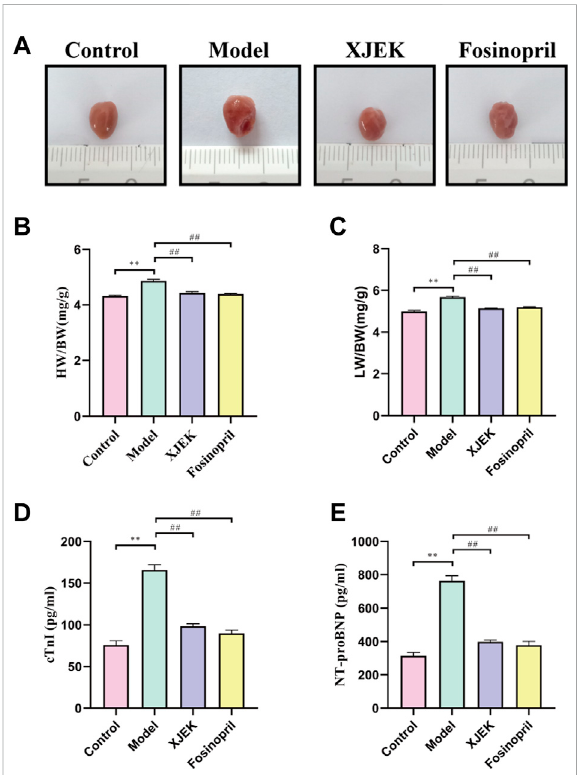
FIGURE 2 XJEK attenuated MIR-induced cardiac injury. (A) Pictures of the hearts from mice. (B) Ratios of heart weight to body weight (mg/g). (C) Ratios of lung weight to body weight (mg/g). Serum cTnI (D) and NT-proBNP (E) levels at 6 weeks post MIR. pp p < 0.01 versus control group, ## p < 0.01 versus MIR model group. Data were expressed as mean ± SD ( n = 6 mice for each